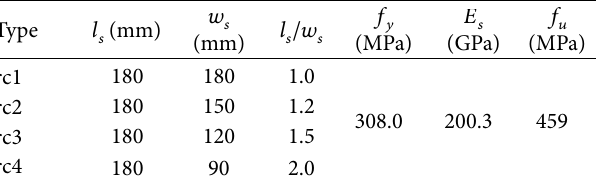
Table 3: Details of rectangular steel